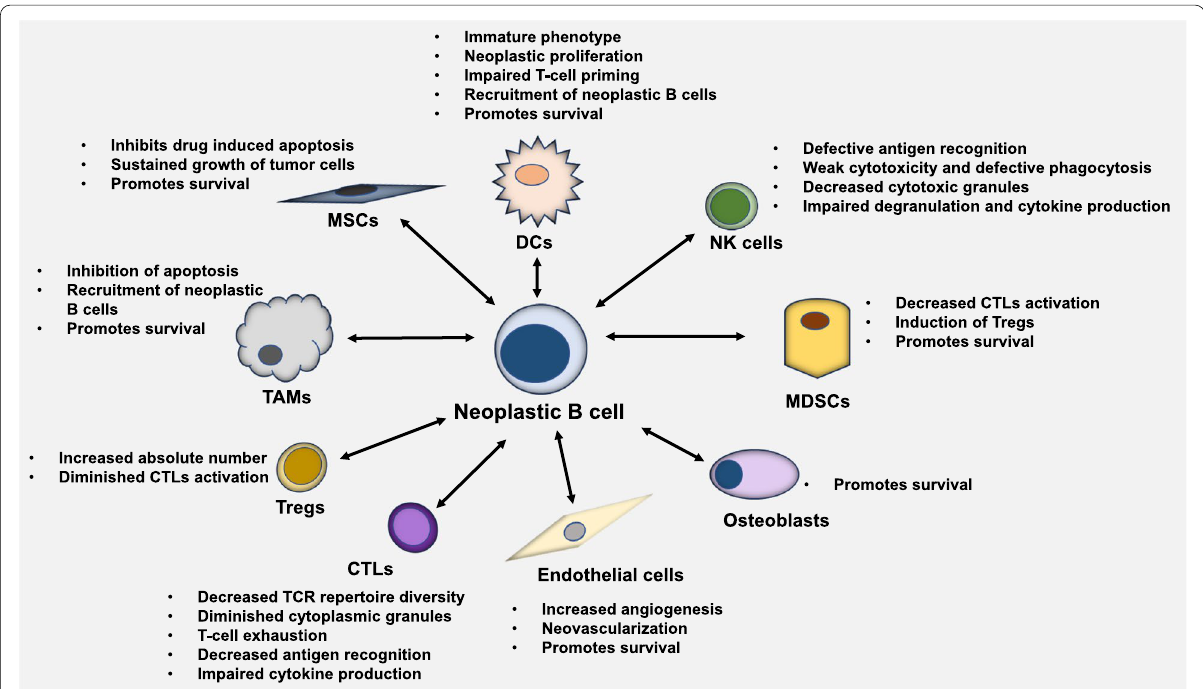
Fig. 3 Interaction with components of tumor microenvironment and immune-driven mechanisms in B-cell